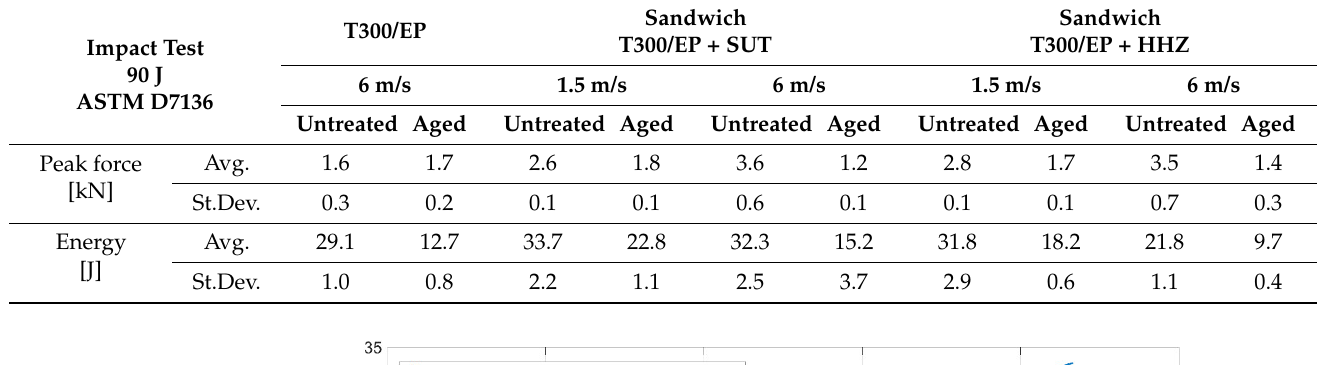
Figure 4. Energy-displacement mean curves for untreated or aged specimens of sandwich with Kraibon HHZ.